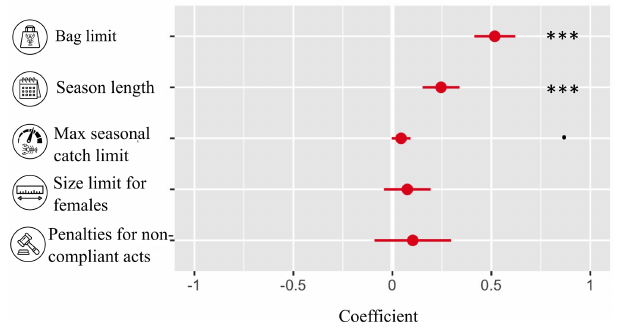
Fig. 5 . Conditional logit model results of the choice experiment responses for all fishers. Error bars indicate standard error (p- values: < 0.001 = ***, < 0.01 = **, < 0.05 = *, < 0.1 = .). See Appendix 1, Table 1 for detailed regression